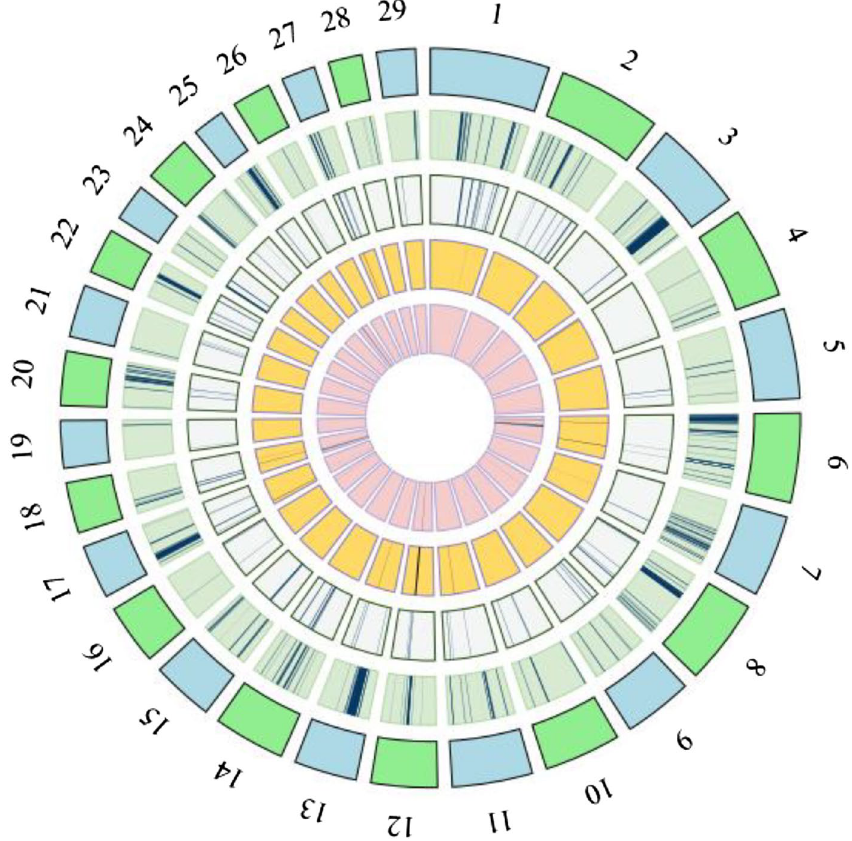
Figure 6. Graphical representation of the proportion of the genome covered by ROH Islands. One different colour is assigned to each breed and the order of breeds is based on the abundance of ROH Islands for a better visualization. From the most external to the centre: Boer (light green), Angora (light blue), Saanen (light orange) and Nubian (light